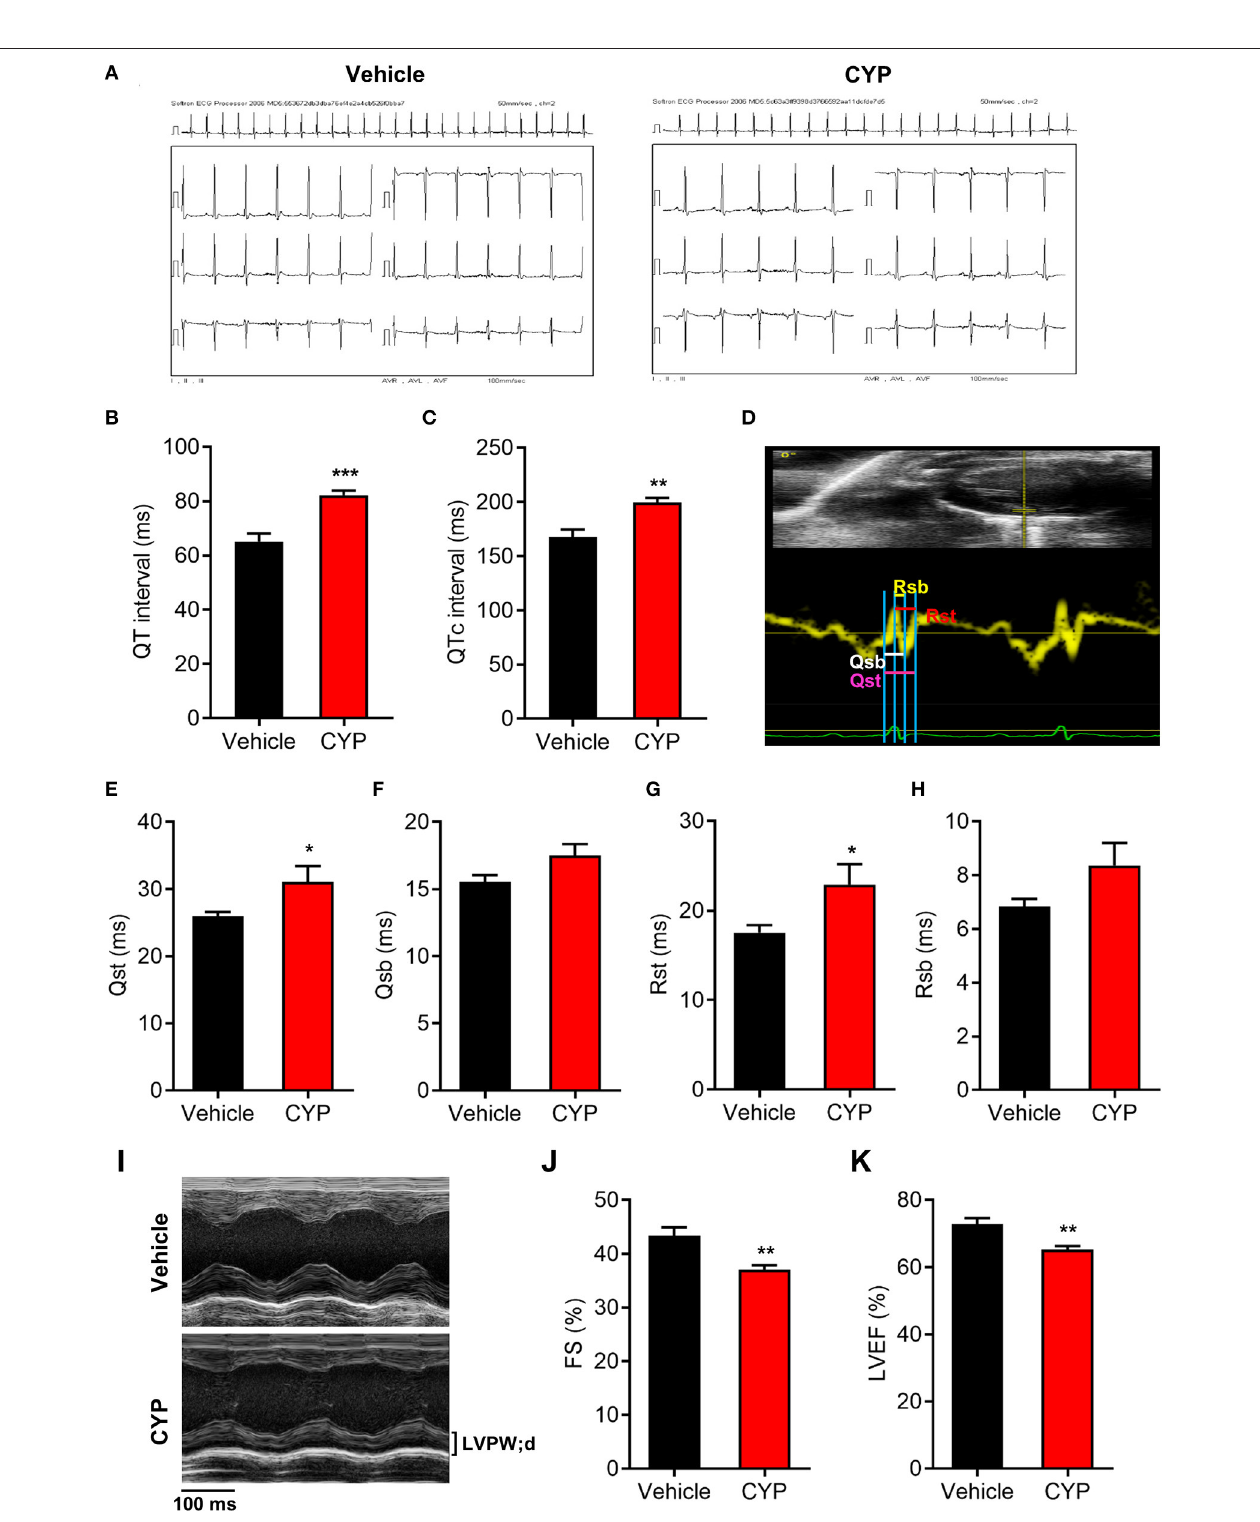
FIGURE 2 | The effect of CYP on QT intervals, cardiac electromechanical coupling and cardiac function. Electrocardiogram recording (A) showing QT intervals (B) and QTc (C) prolongation in rats treated with CYP for 1 day. (D) Schematic of four time courses of cardiac electromechanical coupling in the lateral wall of the left ventricle of rats. Qsb time course is the duration from the onset of Q wave on ECG to the beginning of S wave. Qst time course is the duration from the onset of Q wave on ECG to the top of S wave. Rsb time course is the duration from the top of R wave on ECG to the beginning of S wave. Rst time course is the duration